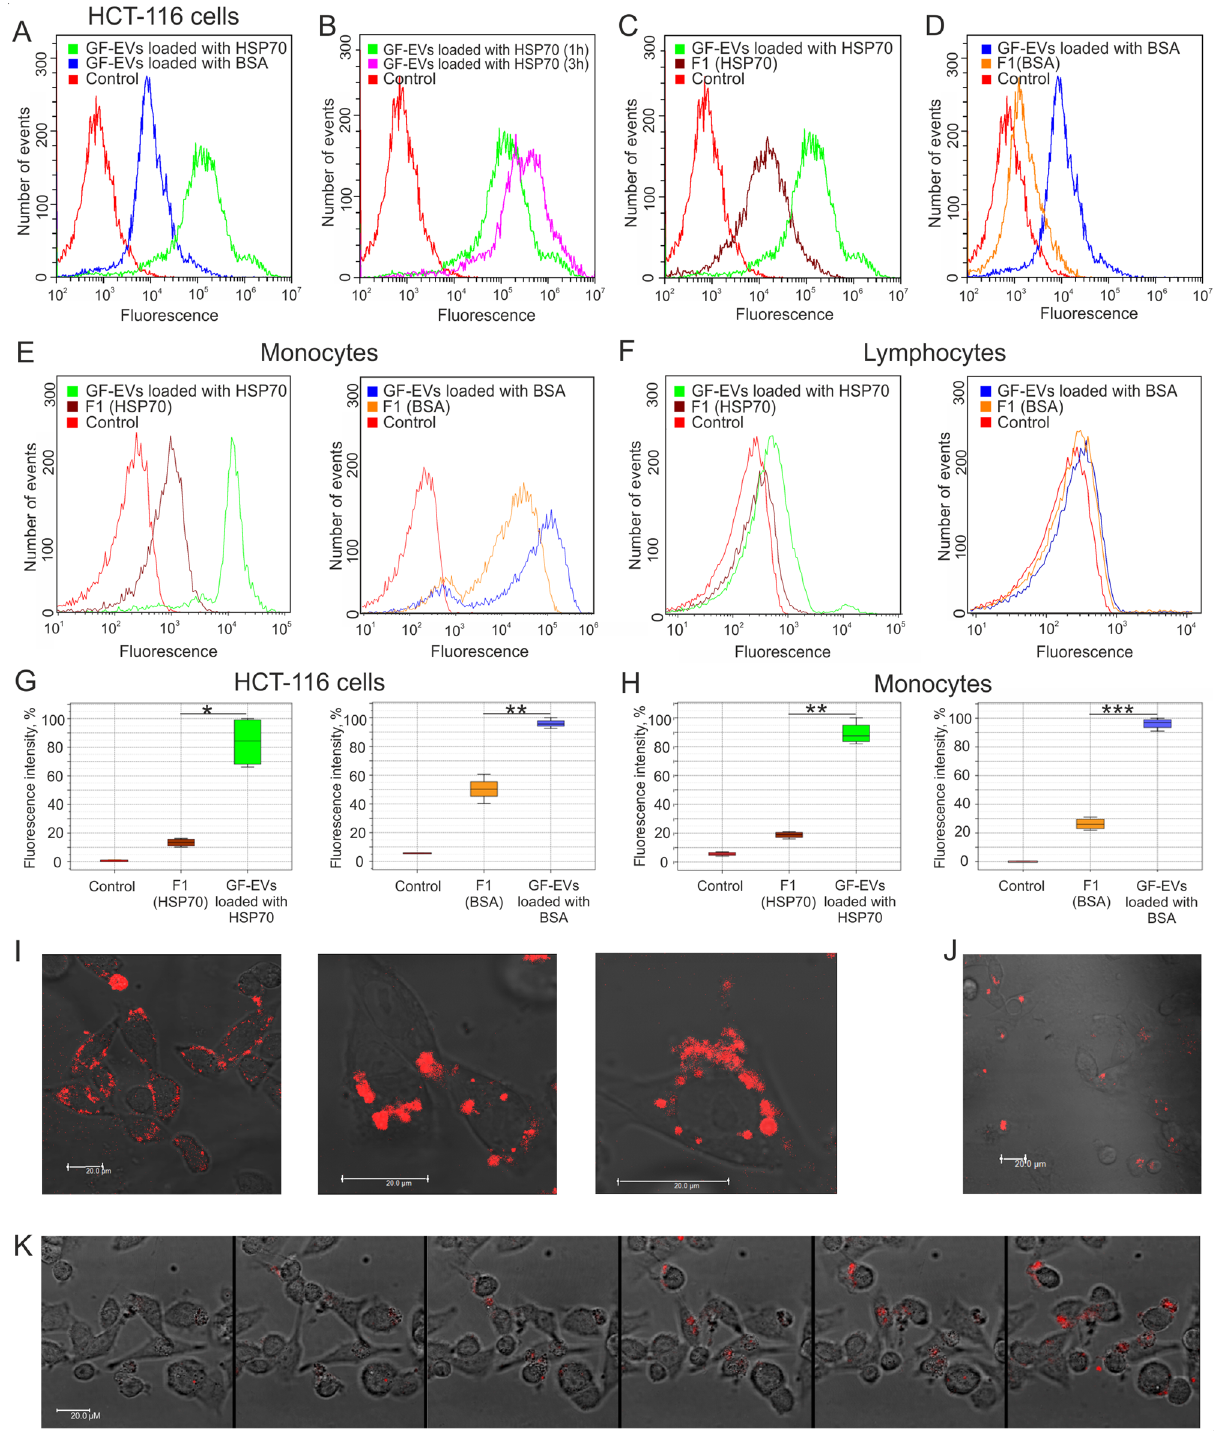
Figure 5. GF-EV-mediated delivery of exogenous proteins into the human cells analyzed by flow cytometry and confocal microscopy. ( A ) Incubation of colon cancer HCT-116 cells with GF-EVs loaded with BSA-AF647 or HSP70-AF647 proteins for 1 h. ( B ) Incubation of HCT-116 cells with HSP70-AF647-loaded GF-EVs for 1 and 3 h. ( C , D ) Incubation of HCT-116 cells with loaded GF-EVs in comparison with the free HSP70-AF647 or BSA-AF647 proteins for 1 h. ( E , F ) Incubation of peripheral blood mononuclear cells ( E , monocytes and F , lymphocytes) with loaded GF-EVs in comparison with the free HSP70-AF647 or BSA-AF647 proteins for 1 h. ( G , H ) The relative intensity of fluorescence of HCT-116 cells and monocytes incubated with loaded GF-EVs in comparison with the free HSP70-AF647 or BSA-AF647 proteins. N = 2. Data are presented as means ± SD. *, p < 0.05, **; p < 0.01; ***, p < 0.001 as estimated by one-way ANOVA followed by multiple comparisons Tukey’s post-hoc analysis. ( I,J ) Micrographs of DLD1 cells co-cultivated with GF-EVs loaded with HSP70-AF647 ( I ) or BSA-AF647 ( J ) proteins. Scale bars are 20 µm. ( K ) Accumulation of fluorescent protein delivered into the recipient DLD1 cells by GF-EVs. Video recording frames were captured every 30 min after adding of loaded GF-EVs to the